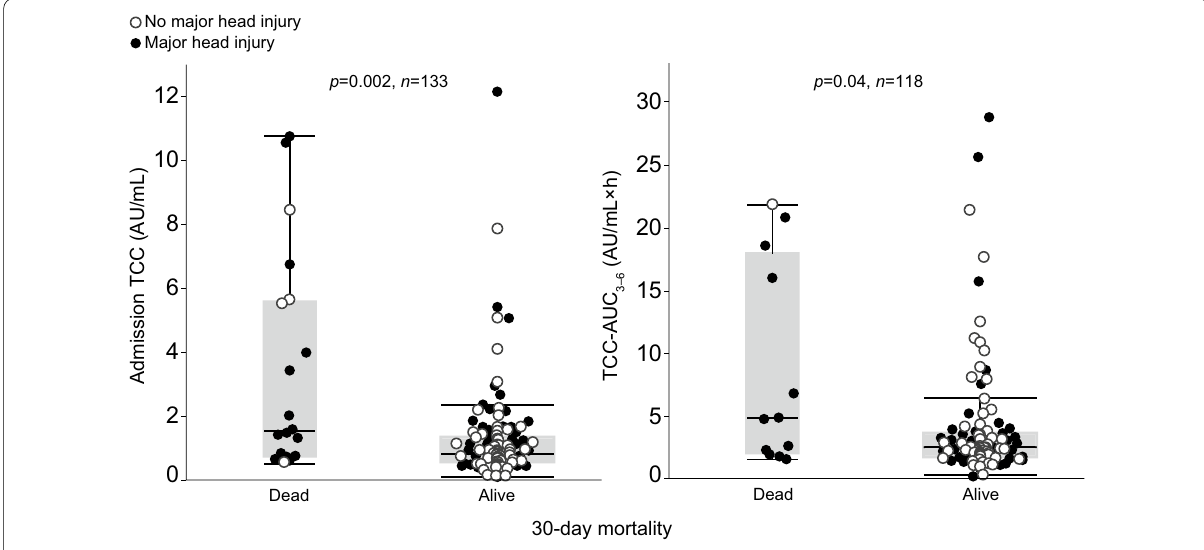
Fig. 6 Mortality. Distribution of admission TCC and TCC-AUC 3–6 for patients who died within 30 days and patients who survived. A total of 20 patients died, 16 of them due to major head injury. All patients who died had admission TCC documented, but TCC-AUC 3–6 could be calculated in only 12 of them due to early deaths (see Figure S2 in Additional file 4). Open symbols represent patients without major head trauma; filled symbols represent patients with major head trauma. Values in the panels are numbers ( n ) and p -values for the total